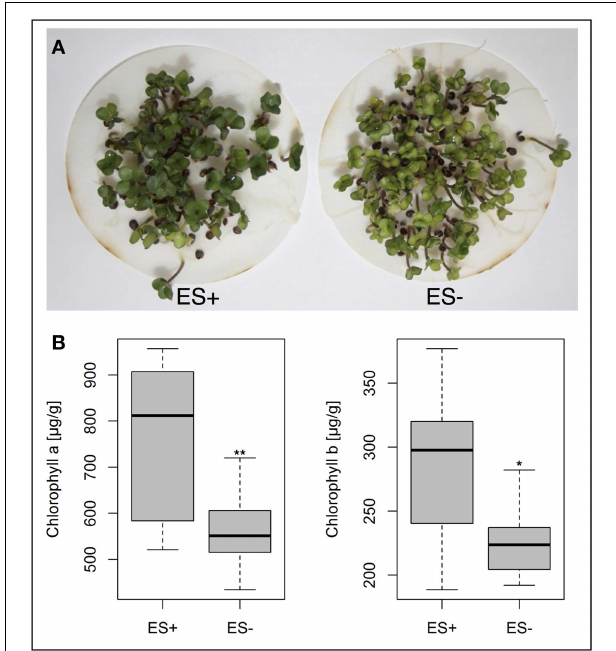
FIGURE 7 | (A) Phenotypic variation for cotyledon chlorophyll pigmentation in B. napus genotypes showing high (ES + ) and low (ES − ) elongation radicle rates. (B) Box plots representing chlorophyll a and chlorophyll b concentrations of 10 genotypes each, showing high and low elongation radicle rates. Significant differences were calculated with student’s t -test at p < 0 . 05* and p < 0 . 01** .